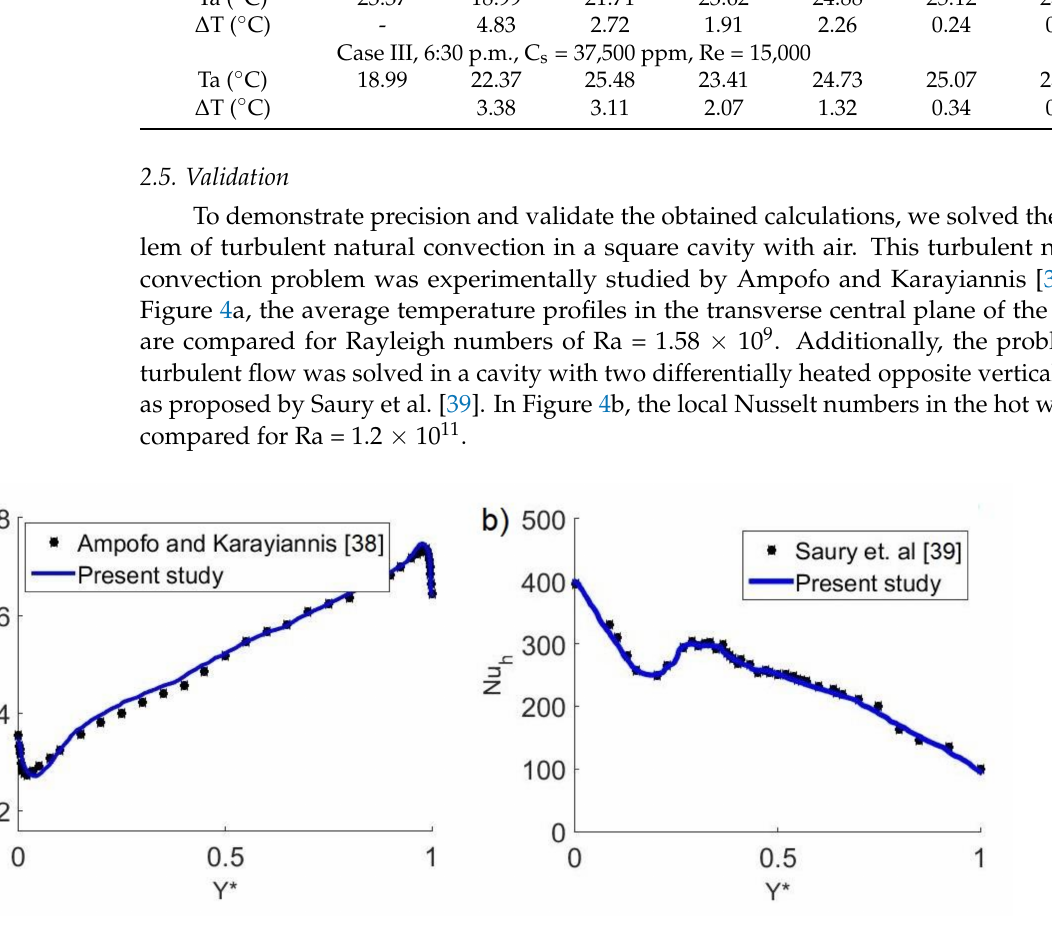
Figure 4. Validation of numerical results: ( a ) Comparison between mean temperatures for turbulent convection in an air-filled square cavity problem as reported by Ampofo and Karayiannis [38]. ( b ) Comparison of local Nusselt numbers along the hot wall for the turbulent convection problem in a differentially heated cavity as reported by Saury et al.